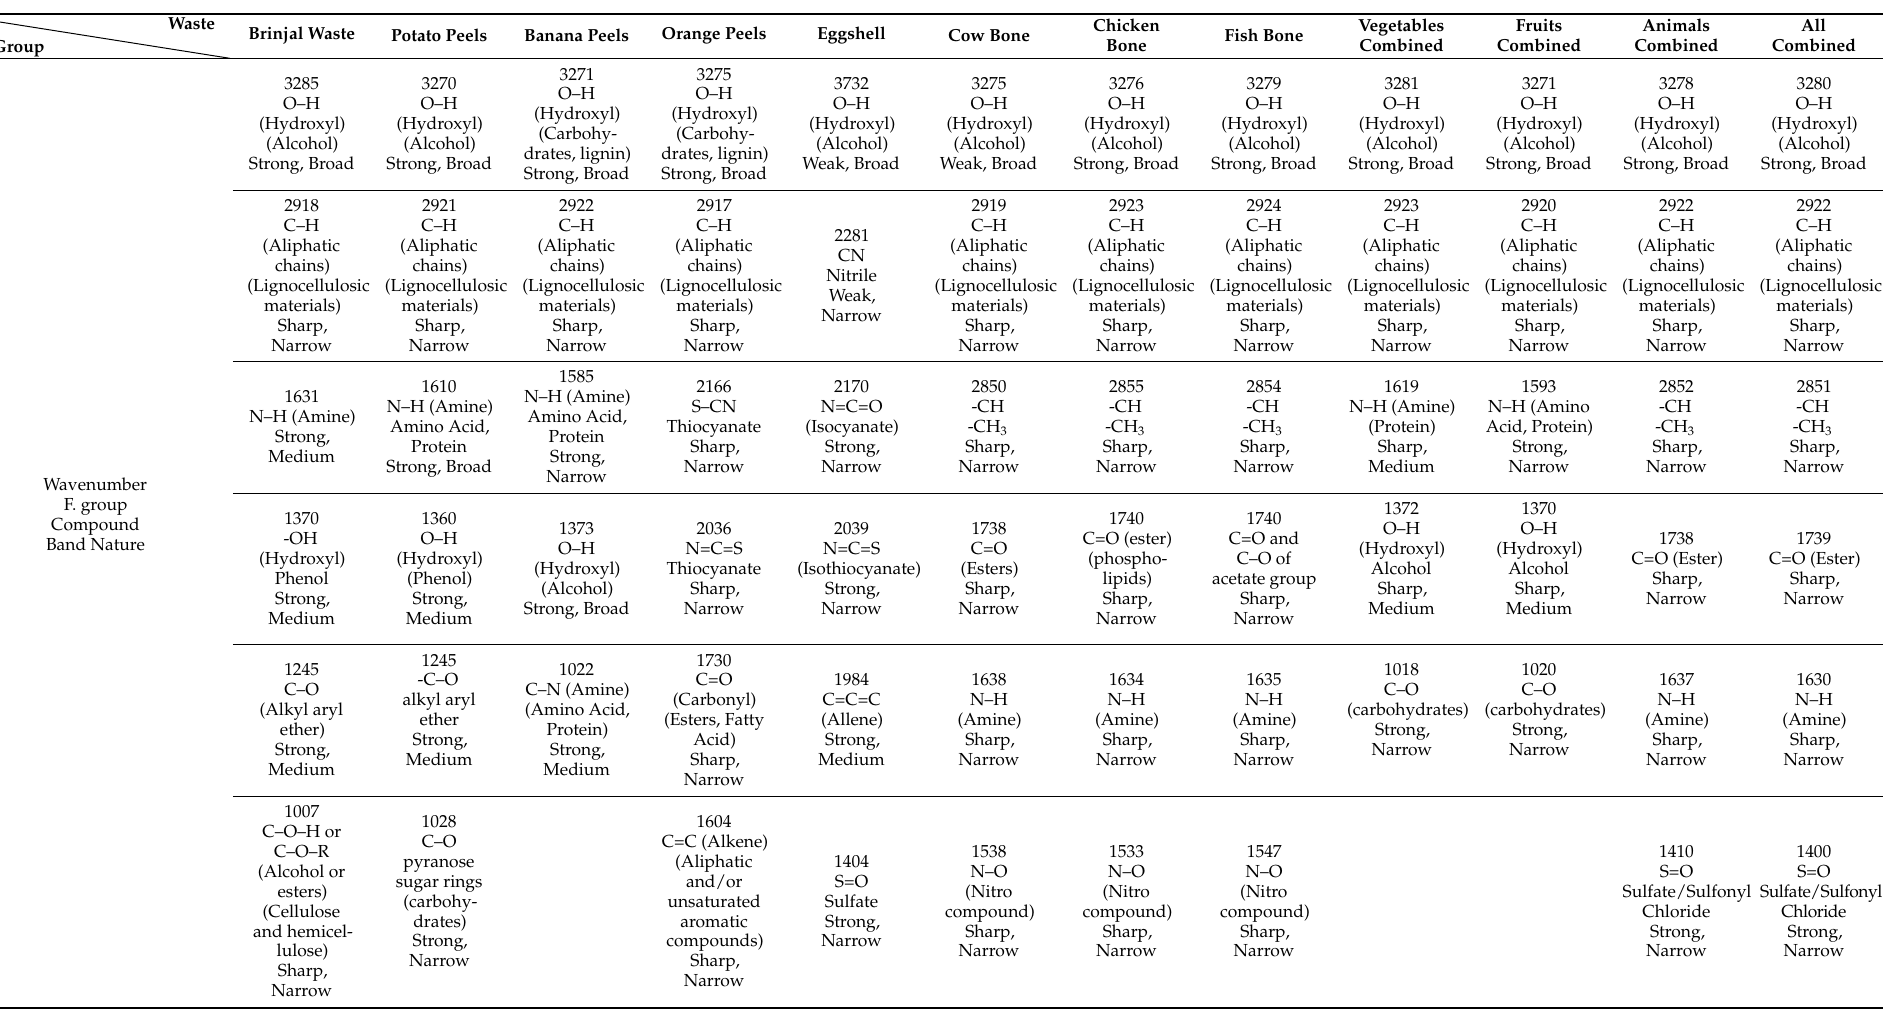
Table 4. Comparison of the functional groups of different